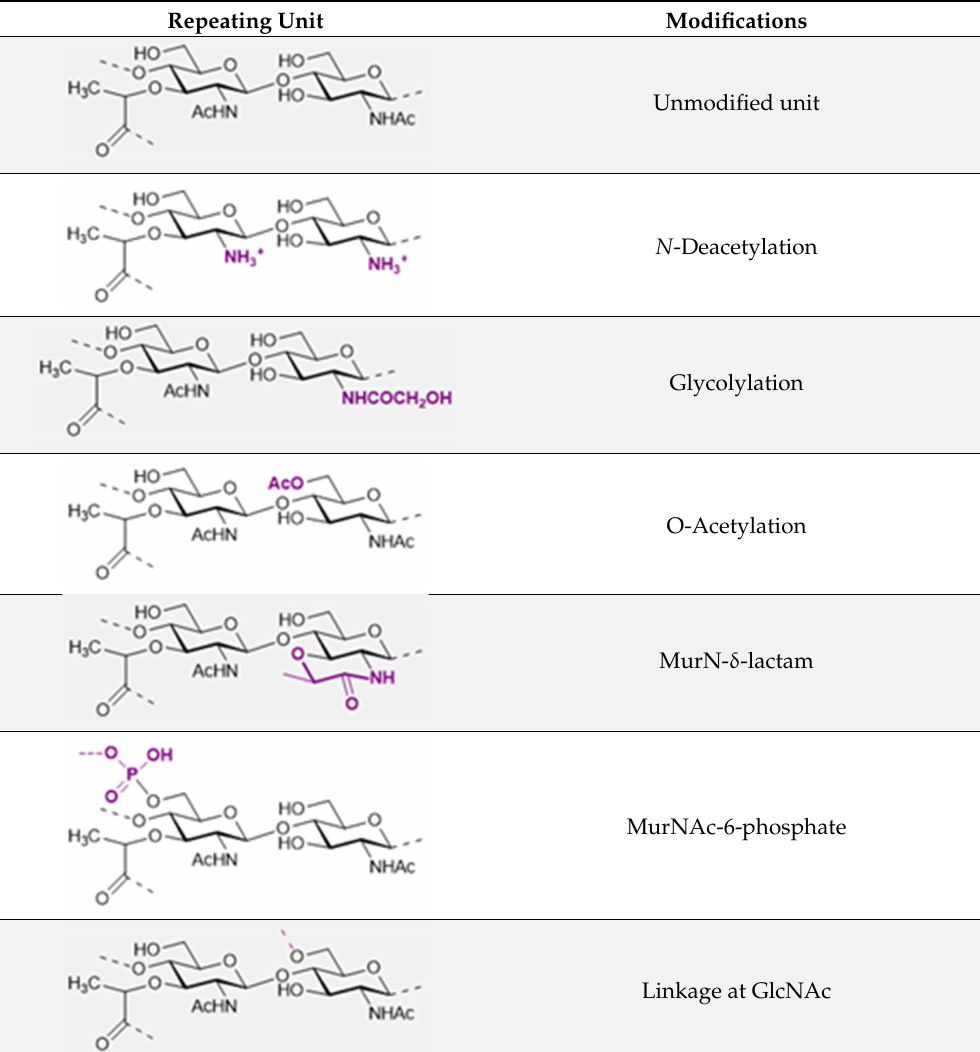
Figure 3. Key structural elements that are representative of the peptidoglycan region. The strands of PG are linked via peptide chains that condense with each other forming amide bonds via either the meso-A2pm carboxyl group or amine group. Table 2. Known modification of the PG repeating